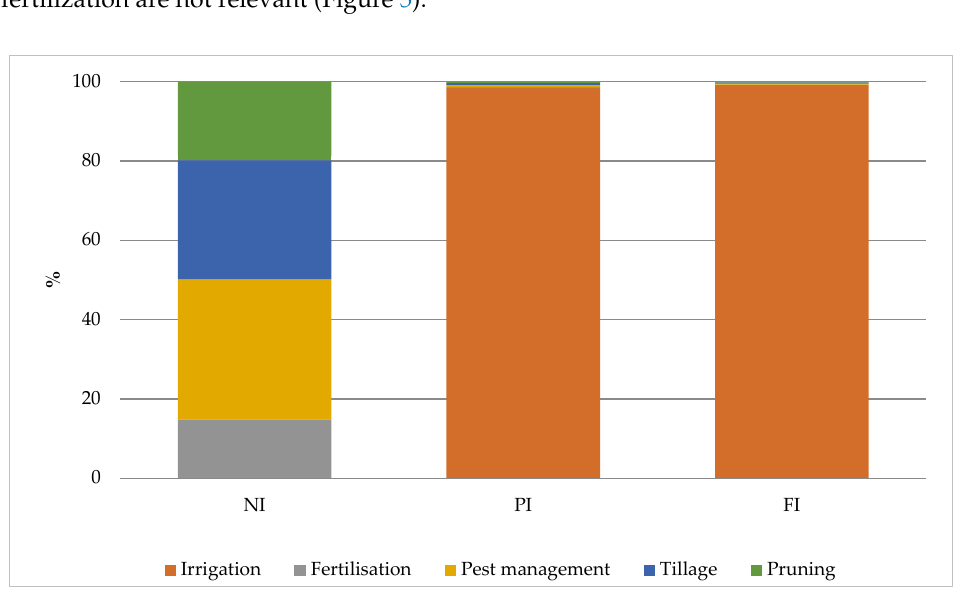
Figure 5. Water footprint per agronomic operation (%).